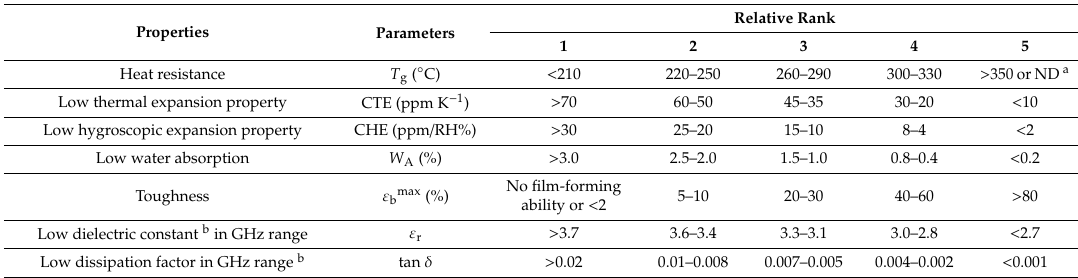
Table 9. Criteria for estimating the performance balance of the PEsIs for use in the dielectric substrates of high-performance